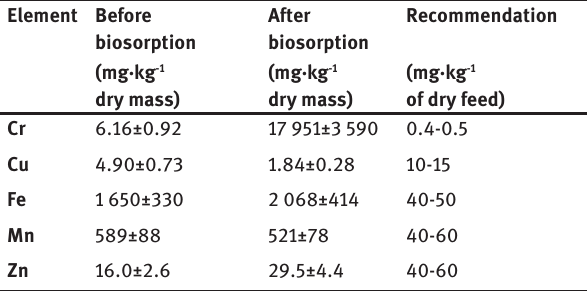
Table 4: Characterization of the biomass before and after biosorption and recommendation for working horses. Element Before